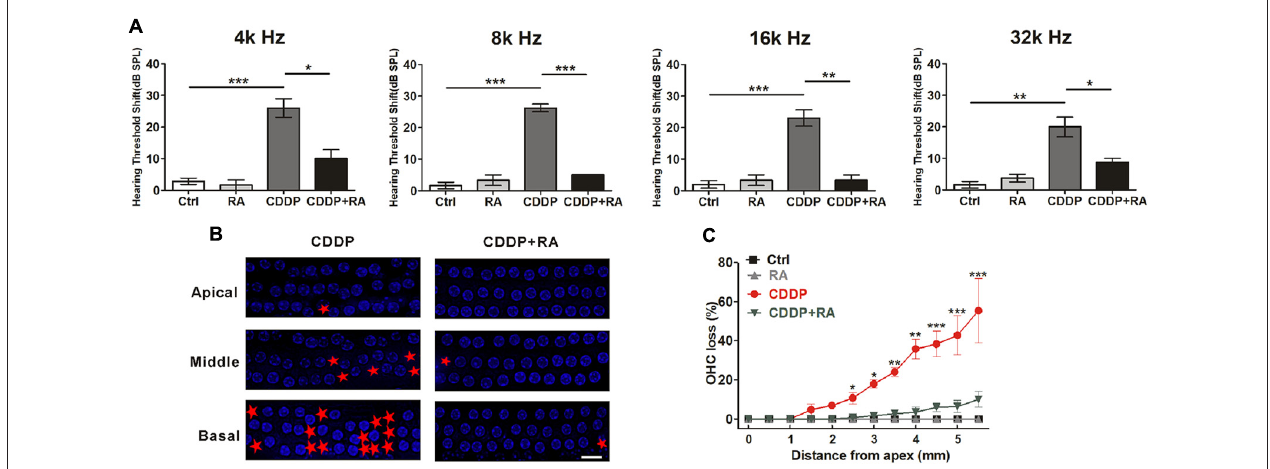
FIGURE 6 | Autophagy activation attenuates cisplatin-induced hair cell loss and hearing loss in C57BL/6 mice. (A) Auditory brainstem response (ABR) thresholds decreased with RA (7.5 mg/kg, intraperitoneal injection pre-24 h, pre-1 h, post-24 h) treatment mice in CDDP (16 mg/kg, intraperitoneal injection) exposure compared with the CDDP groups at 4, 8, 16 and 32 kHz ( n = 6 mice). (B,C) Surface preparations were stained with 4 (cid:48) ,6-diamidino-2-phenylindole (DAPI). Hair cell counts obtained for the CDDP and CDDP+RA group ( n = the right cochlea of six mice). Scale bar, 10 µ m. Data represent the mean ± SEM. ∗ p < 0.05, ∗∗ p < 0.01, ∗∗∗ p < 0.001. Control, mice were intraperitoneally injected with the same dose DMSO as the CDDP group; RA, mice were intraperitoneally injected with rapamycin three times; CDDP, mice were intraperitoneally injected with CDDP; CDDP+RA, mice were intraperitoneally injected with CDDP once and rapamycin three times. CDDP, cisplatin; RA, rapamycin; Apical, the apical turn; Middle, the middle turn; Basal, the basal turn; Red asterisks, lost hair cells.